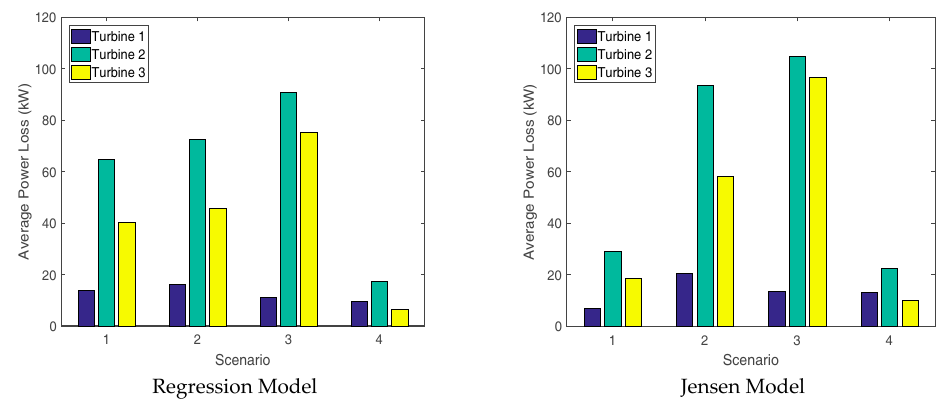
Figure 9. Results for the scenario analysis for the regression model ( left ) and the Jensen model ( right ).